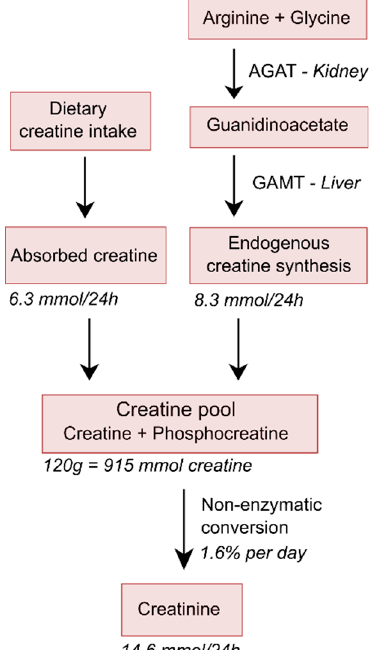
Figure 1. Simplified schematic overview of creatine homeostasis. It has been estimated that young 70 kg-weighing men with normal muscle mass contains about 120 g of total creatine (creatine and phosphocreatine), which equals 915 mmol of creatine, since its molecular weight is 131 g / mol. With a conversion rate of 1.6% per day, and the slightly lower molecular weight of creatinine of 113 g / mol, this will result in a daily 24 h urinary creatinine excretion of approximately 1.65 g, which is equivalent to 14.6 mmol, and thus also equivalent to a loss of 14.6 mmol of creatine, which implies a loss of 1.91 g of creatine per day. The average diet of young omnivorous 70 kg-weighing men has been estimated to contain 7.9 mmol of creatine per day, which with an intestinal absorption rate of 80%, will result in an uptake of creatine from the diet of 6.3 mmol / day, resulting in requirement of endogenous creatine synthesis at a rate of 8.3 mmol / day required to remain in steady state. Because of their lower muscle mass and dietary intake, rates for women would be about 70–80% of that in men [27].